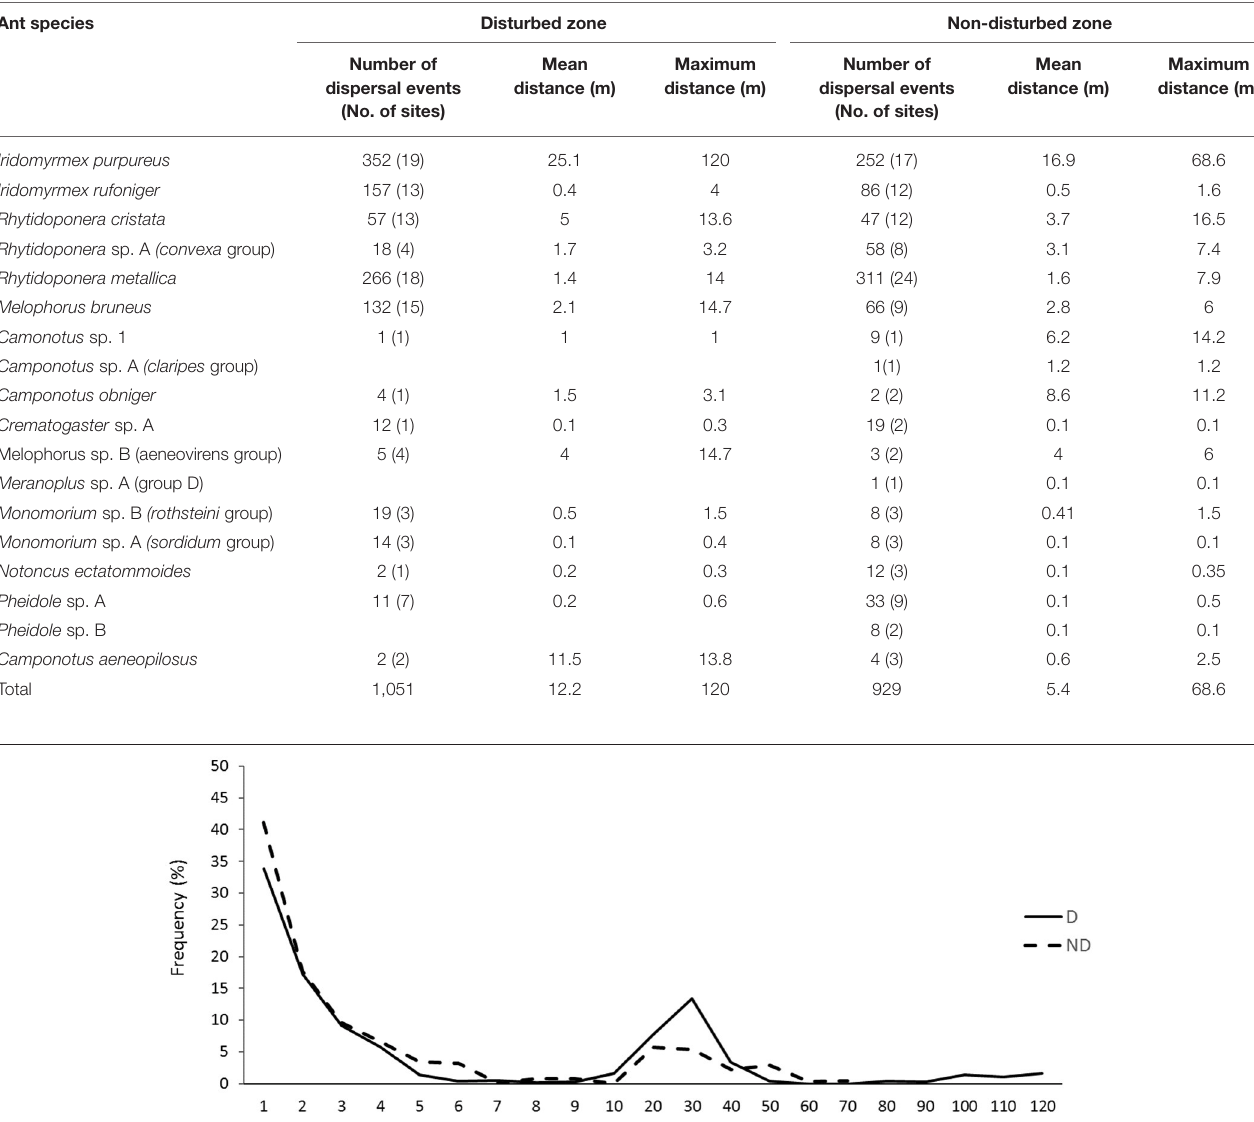
TABLE 1 | Number of seed dispersal events, number of sites ( n = 24) each species occurred at, and mean and maximum dispersal distances, recorded for ant species in disturbed and non-disturbed roadside sites in southern NSW, Lockhart Shire.